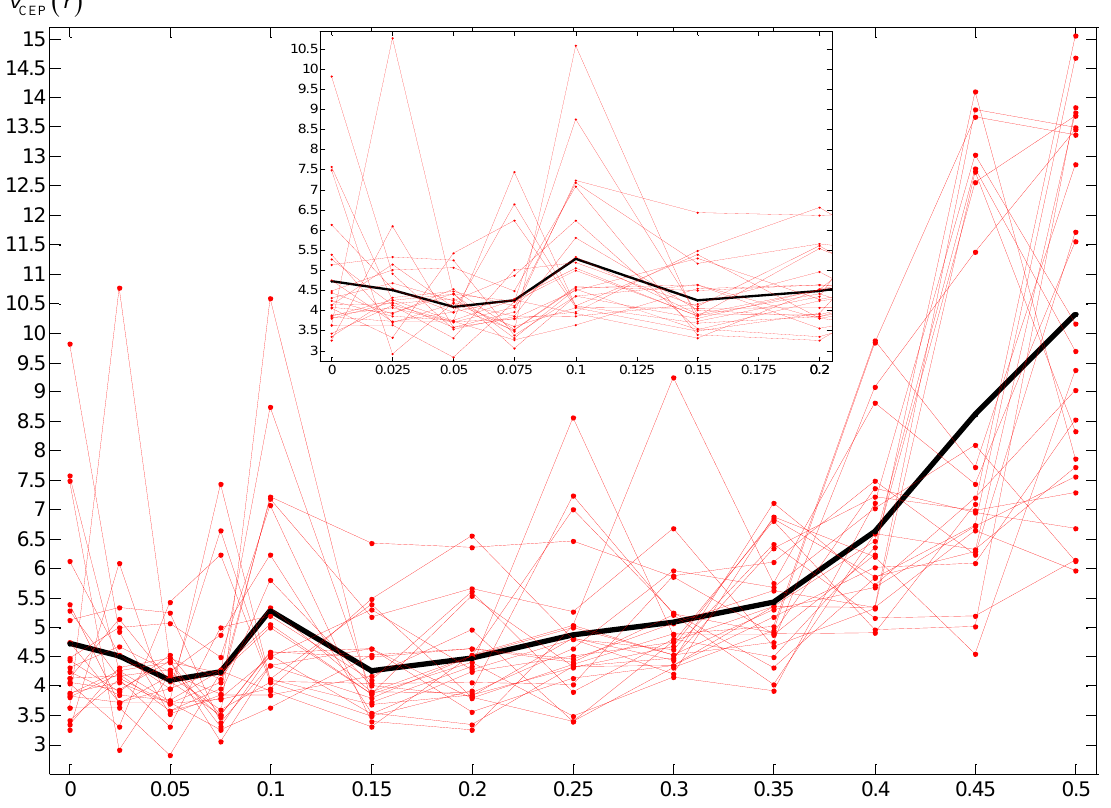
Fig. 5. All 25 polylines making the evaluation in Fig. 4 (the evaluation is drawn with solid line).